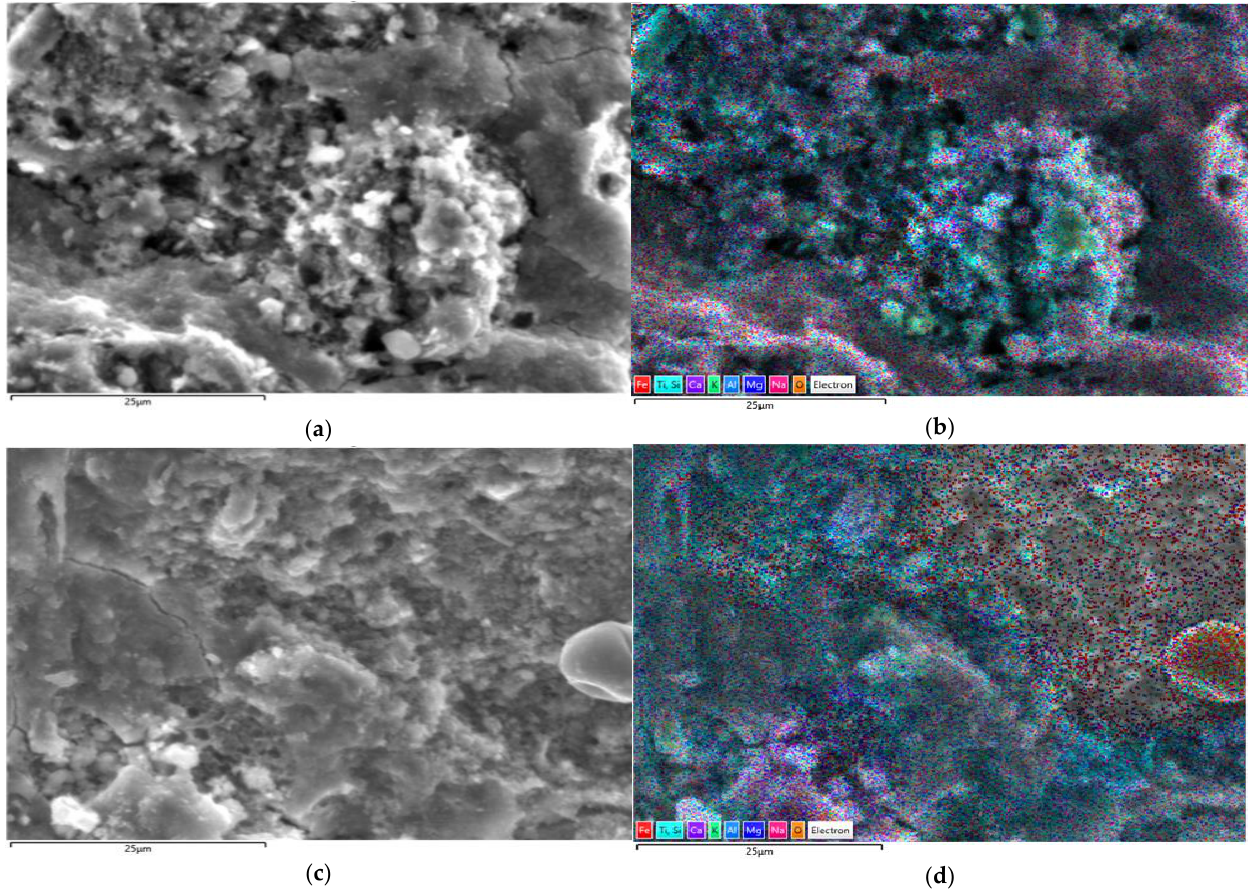
Figure 10. EDS analysis for sample 6M: ( a ) SEM image of selected area and ( b ) EDS stratified image of selected area; for sample 6MX1: ( c ) SEM image of selected area and ( d ) EDS stratified image of selected area.